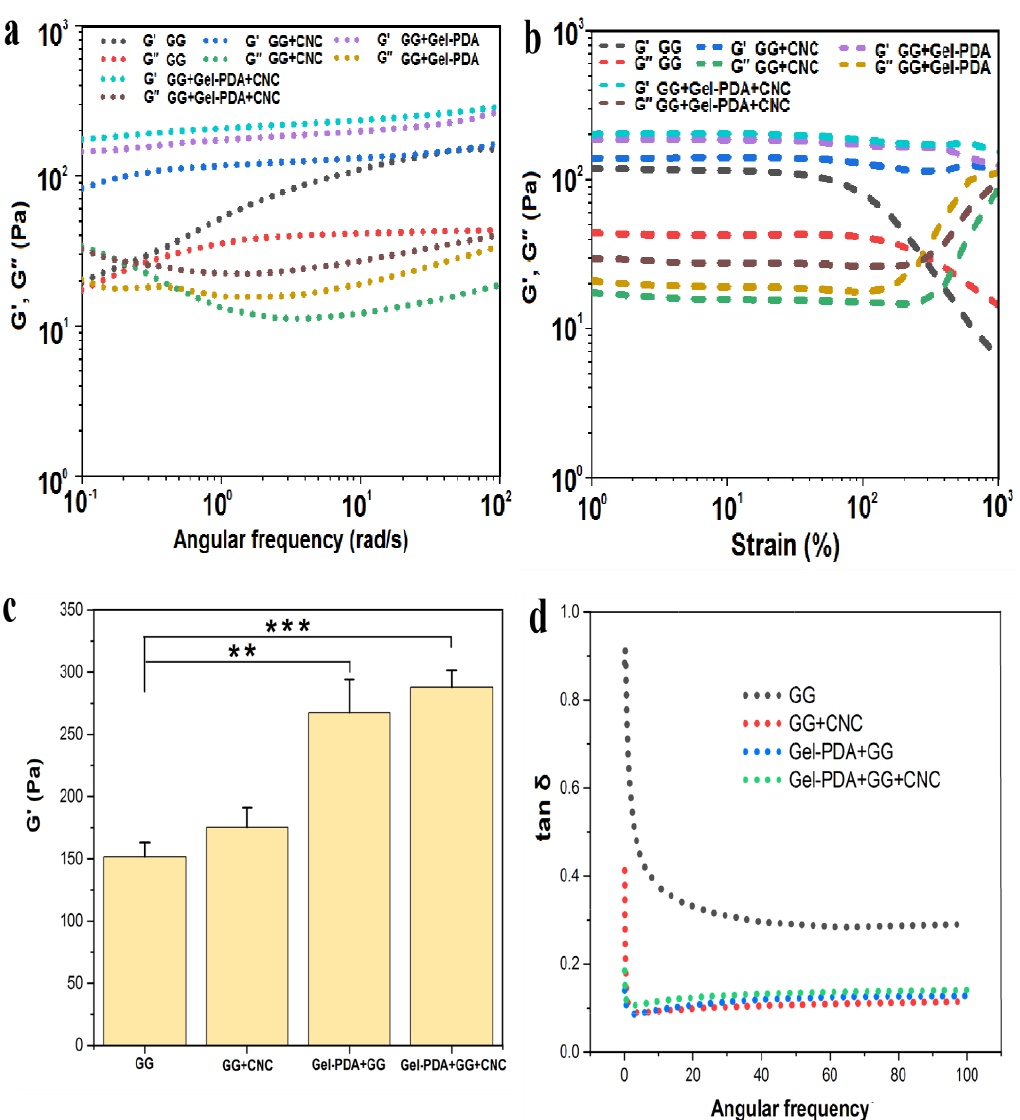
Figure 3. Rheological analysis of hydrogels. ( a ) Frequency sweep analysis, ( b ) strain sweep analysis, ( c ) the highest storage modulus (G’) of hydrogels, ( d ) the loss factor (tan δ ) based on the frequency sweep (**P < 0.01, ***P < 0.001).